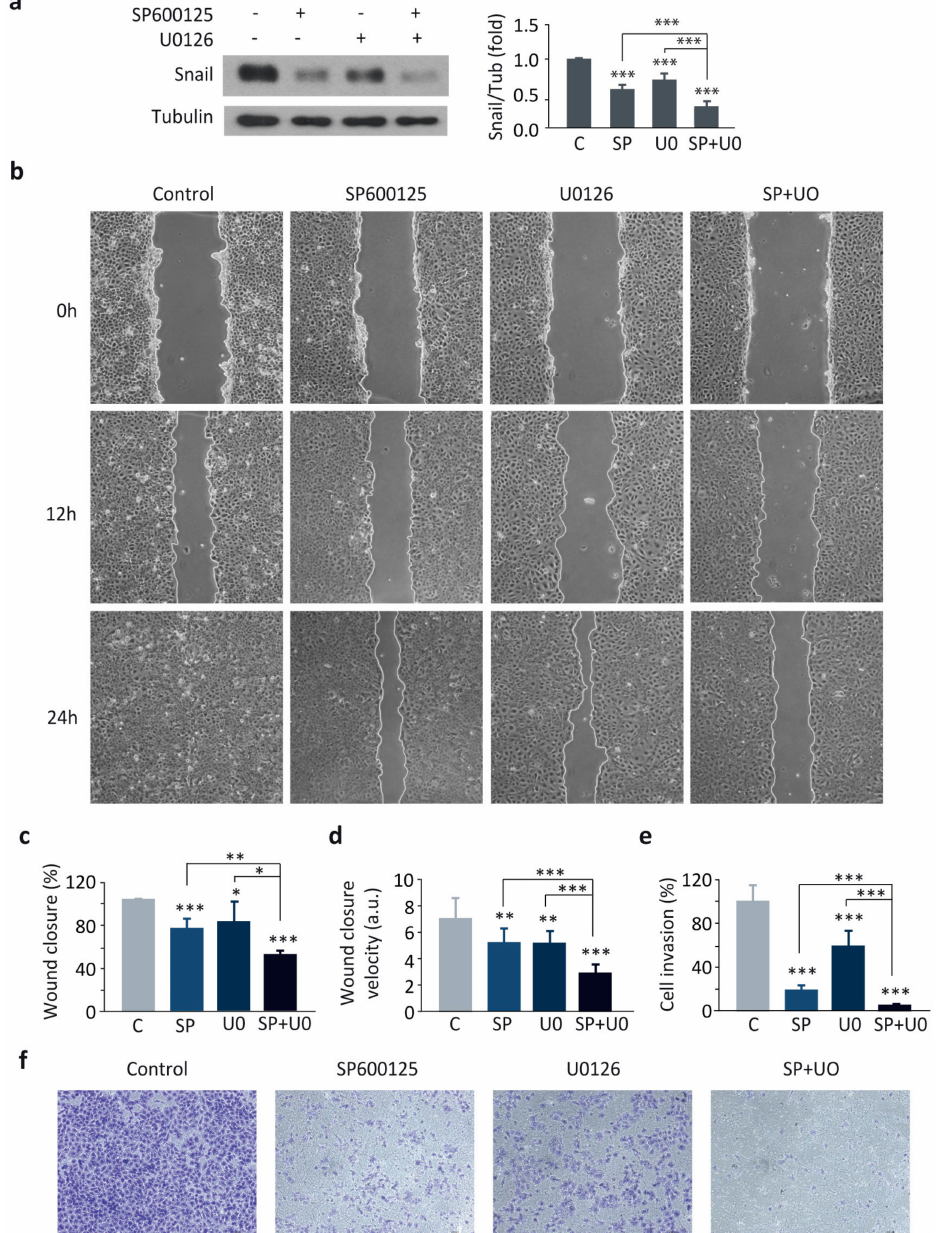
Figure 6. JNK and ERK cooperatively regulate Snail expression, cell migration and invasion in DU145 cells. Cells were incubated in the absence (C) or presence of 10 µ M SP600125 (SP, 24 h) and 20 µ M U0126 (U0, 48 h). ( a ) Expression levels of Snail and Tubulin were determined by western blotting. ( b – d ) Wound healing assay and measurement of wound closure area and velocity. ( e , f ) Invasion capacity using transwell assays. For all the results, data are shown as the mean ± SEM of at least three independent experiments. For migration and invasion assays, pictures are from one representative experiment of three with similar results. Student’s t test: * 0.01 < p < 0.05; ** 0.001 < p < 0.01; *** p <